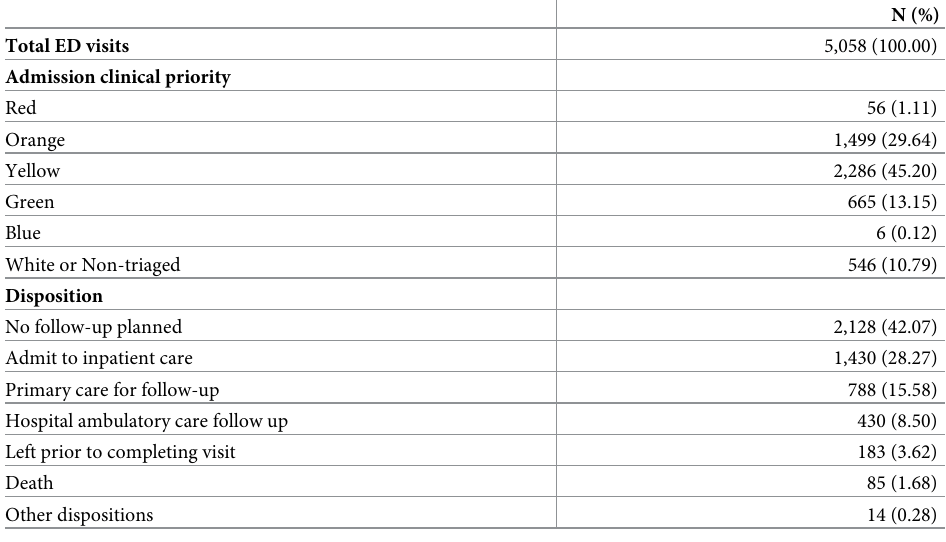
Table 3. Characteristics of ED visits within 30 days after